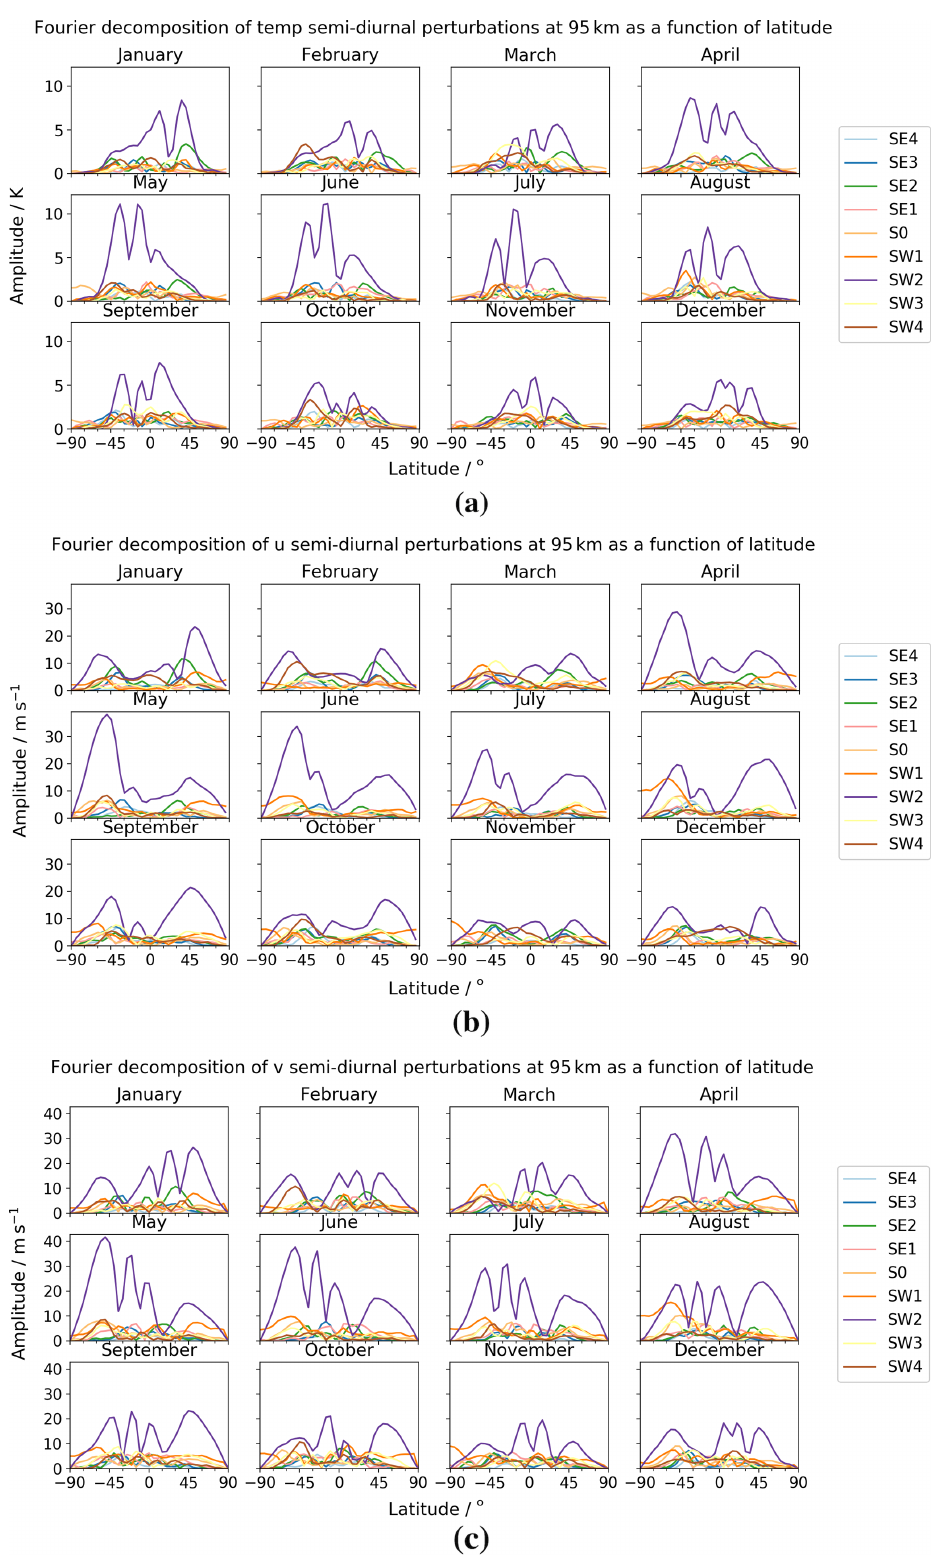
Figure 13. Latitude–amplitude plot of semidiurnal tidal amplitudes across the year for (a) temperature, (b) zonal ( u ) winds, and (c) meridional ( v )